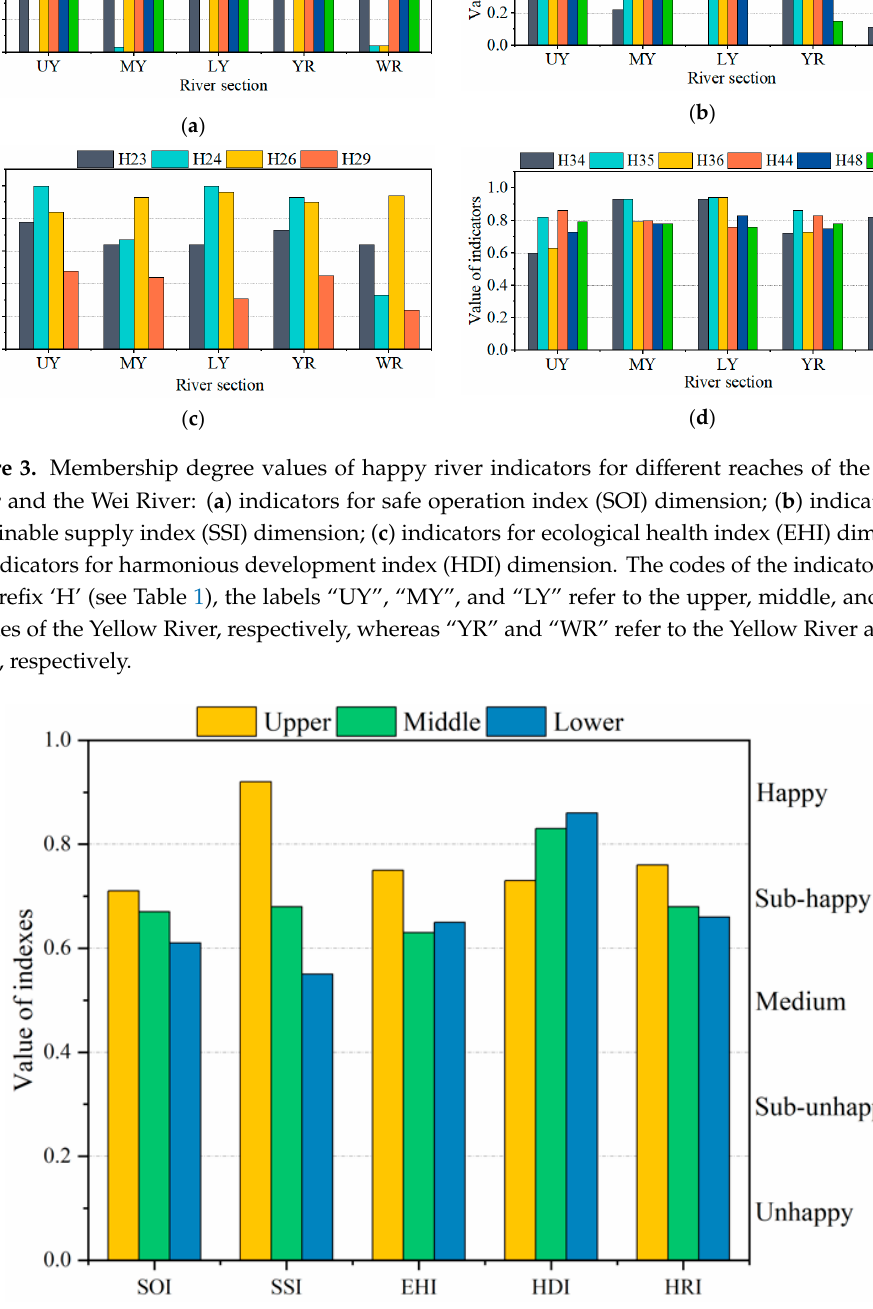
Figure 4. Results of the happy river evaluation for the upper, middle, and lower reaches of the Yellow River.